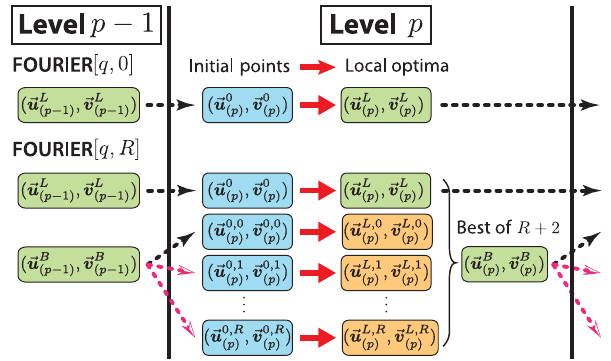
; ⃗ v L Þ is the ð p Þ ð p Þ